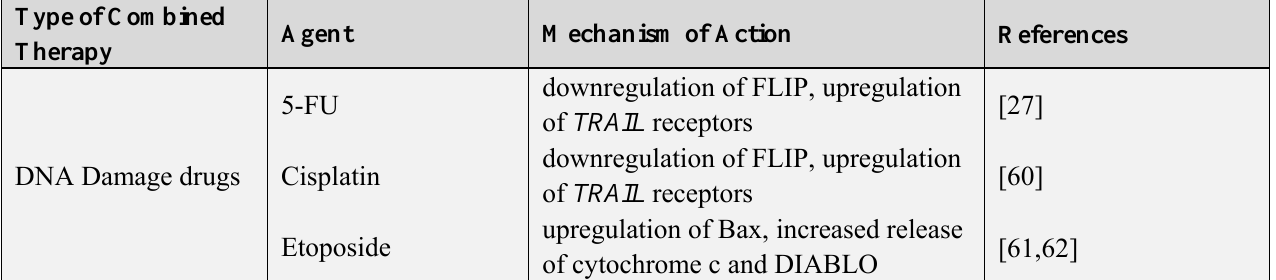
Table 2. TRAIL based combined